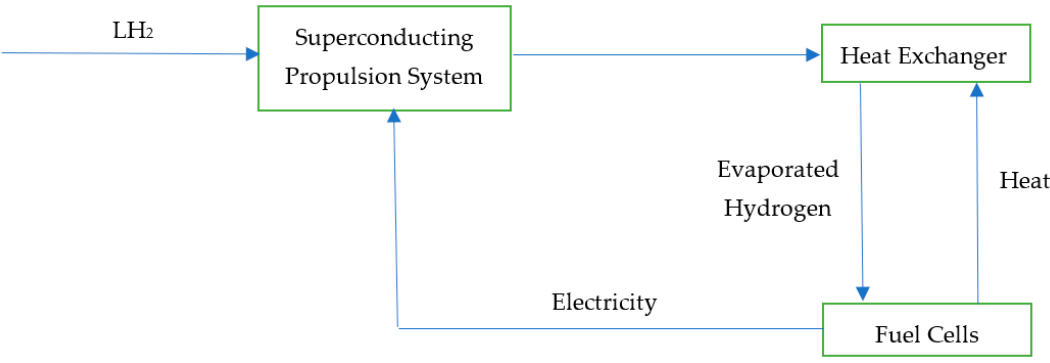
Figure 3. Synergy of LH 2 and superconductivity in a marine vessel.